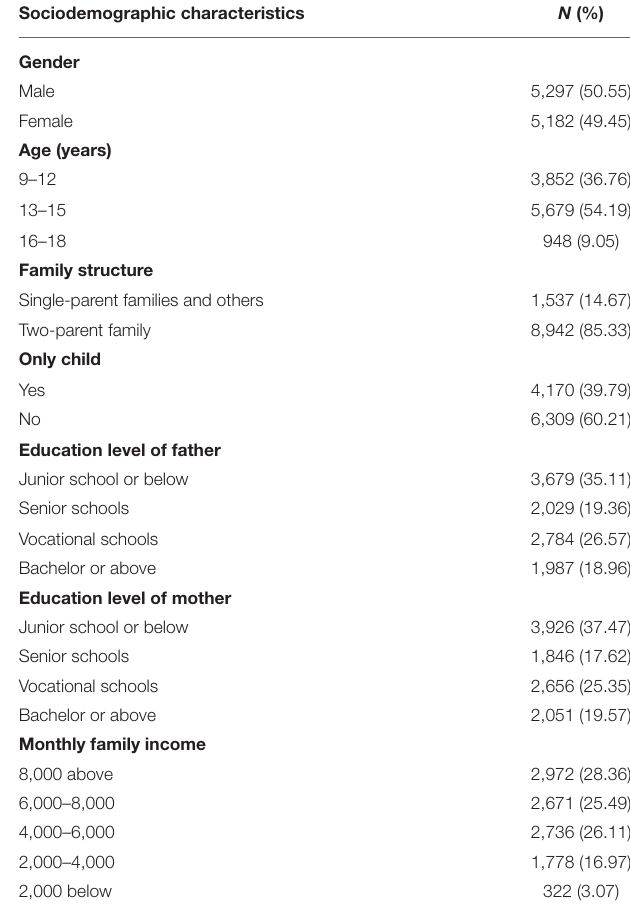
TABLE 1 | Participant sociodemographic